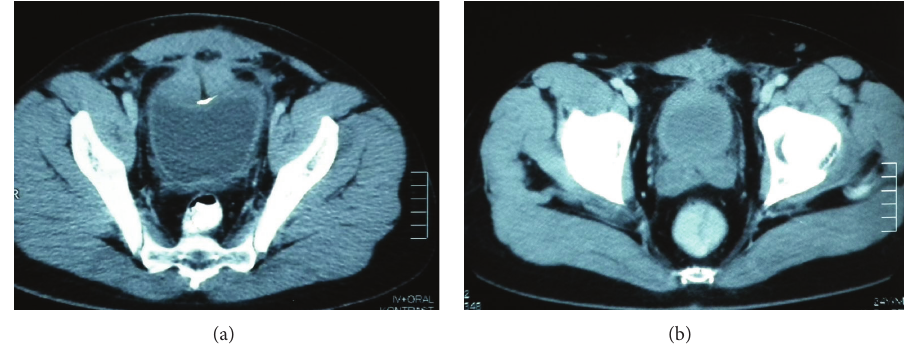
Figure 1: (a) A computed tomography (CT) scan of the abdomen and pelvis showing a mass lesion, involving the dome of the urinary bladder, invading the rectus fascia and muscles. (b) CT scan of the abdomen and pelvis showing no evidence of the mass at the postoperative 6th month.